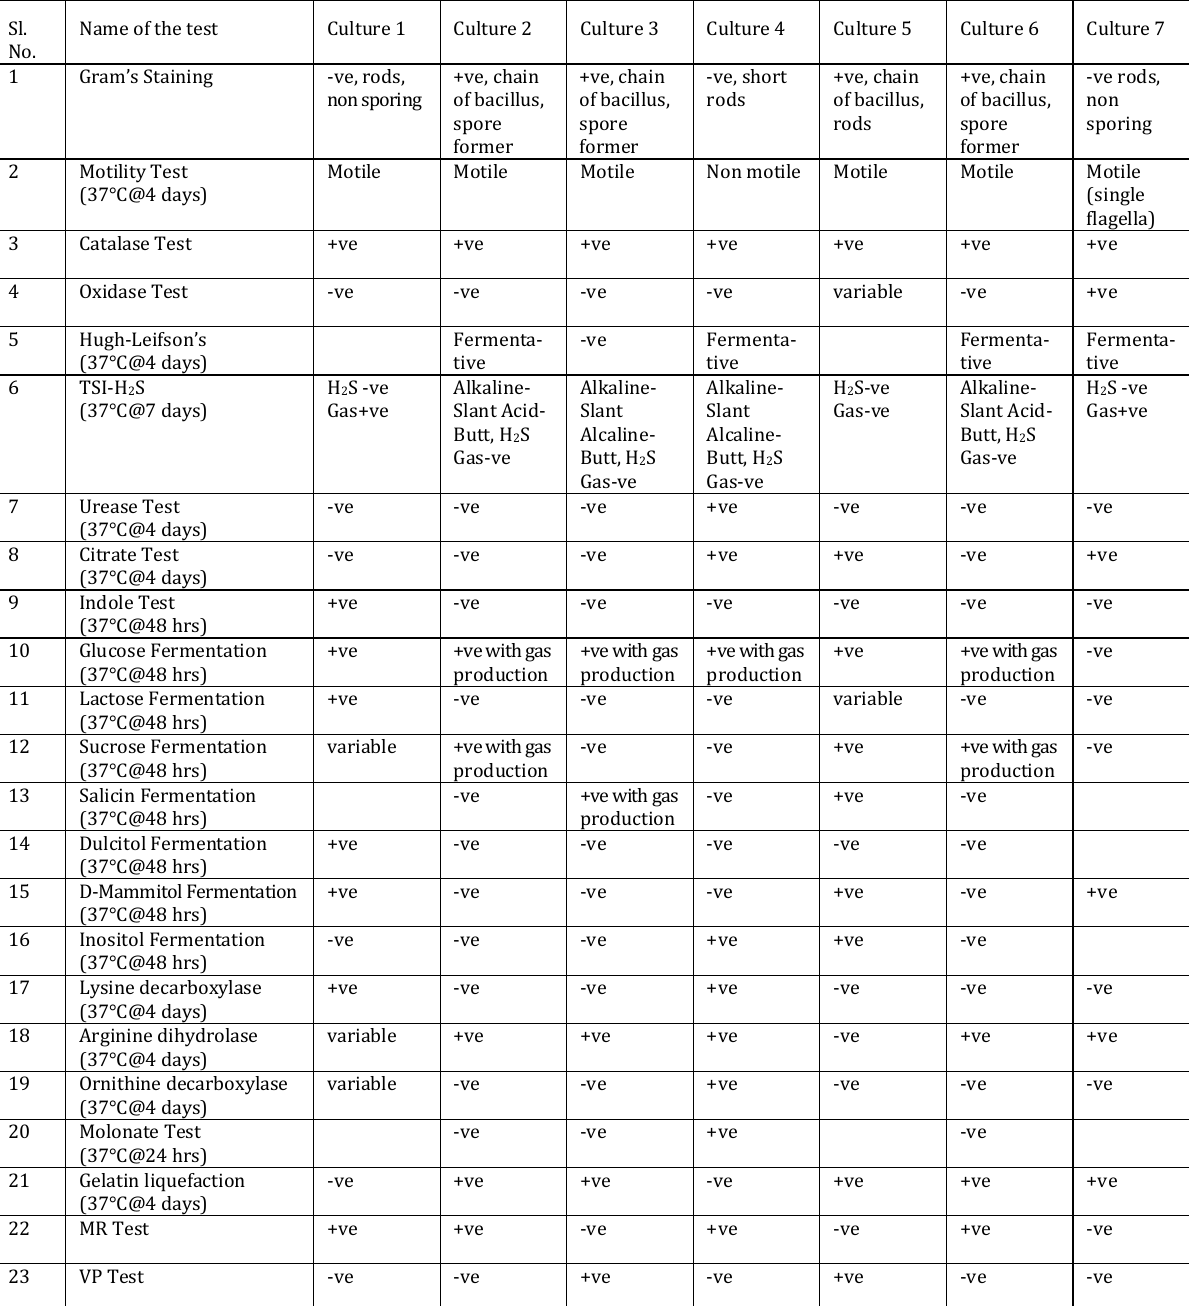
Table 3. Biochemical tests and colony characteristics of various bacterial